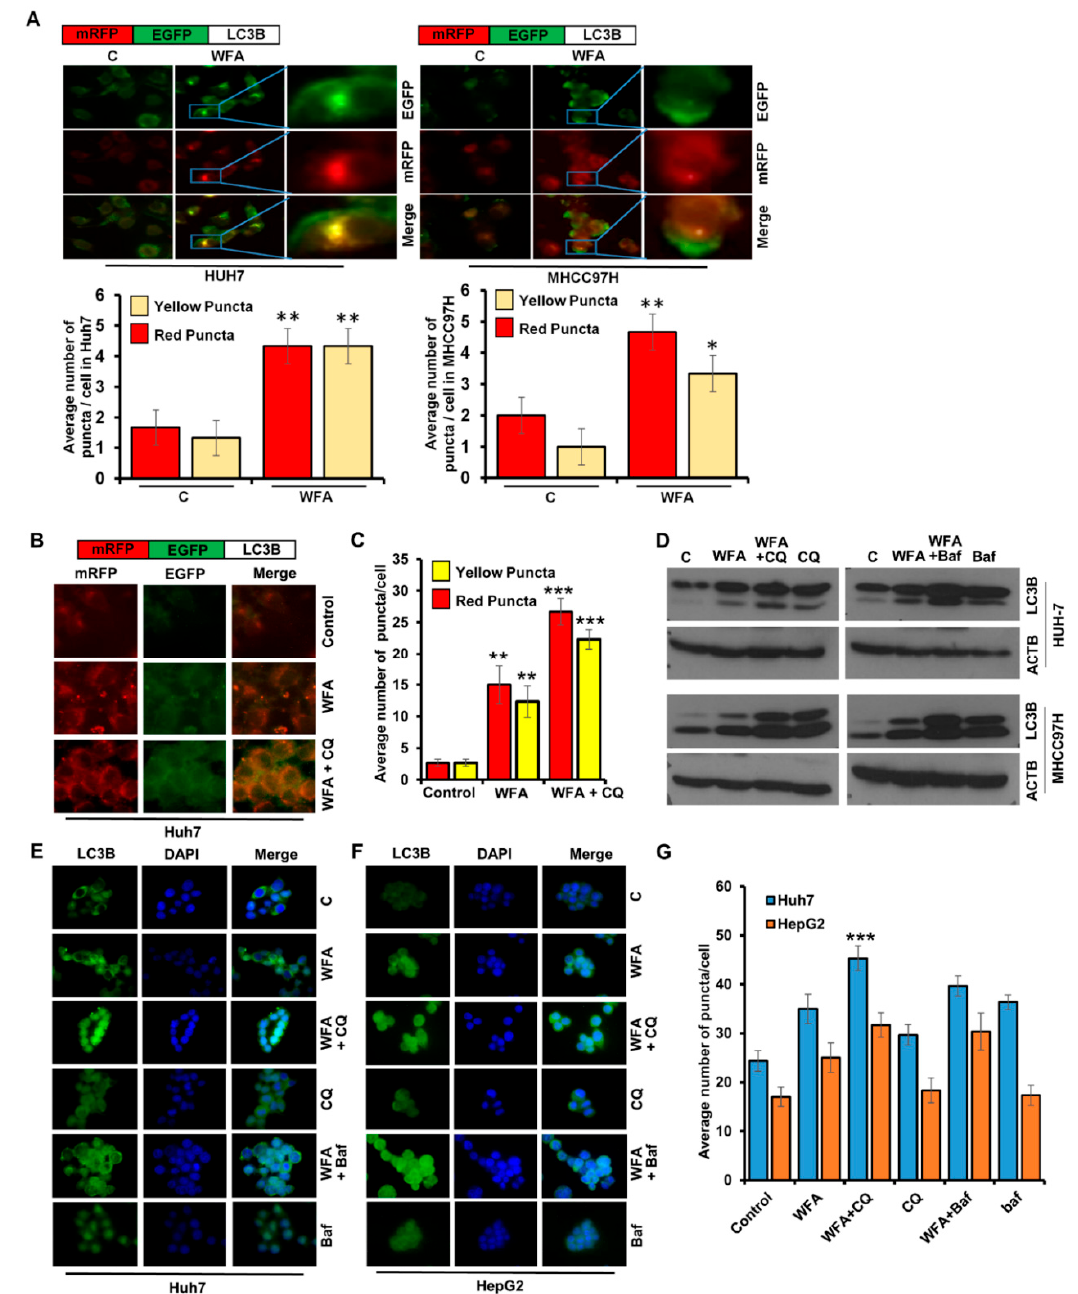
Figure 3. Withaferin A increases the autophagic flux in HCC cells. ( A ) Upper panel represent the schematic diagram of tfLC3B. Huh7 and MHCC97H cells were transfected with tfLC3B and treated with 5 µ M WFA or EBSS. Representative images are shown. Red and yellow puncta were counted and shown as bar diagram. * p < 0.05, compared with control; ** p < 0.01, compared with control, Scale bar 10 µ m. ( B , C ) Upper panel represent the schematic diagram of tfLC3B. Huh7 cells were transfected with tfLC3B and treated with 5 µ M WFA in combination with 25 µ M CQ. Representative images are shown. Red and yellow puncta were counted and shown as a bar diagram. ** p < 0.01, compared with control; *** p < 0.001, compared with control, Scale bar 10 µ m ( D ) Huh7 and MHCC97H cells were treated with 5 µ M WFA in combination with 25 µ M CQ and 200 nM bafilomycin and subjected to immunoblot analyses for the expression level of LC3B. ACTB served as the loading control. ( E – G ) Huh7 and MHCC97H cells were treated with 5 µ M WFA in combination with 25 µ M CQ and 200 nM bafilomycin and subjected to immunofluorescence analyses for LC3B. Representative images are shown. Green puncta were counted and shown as bar diagram. *** p < 0.001, compared with WFA alone, Scale bar 10 µm.